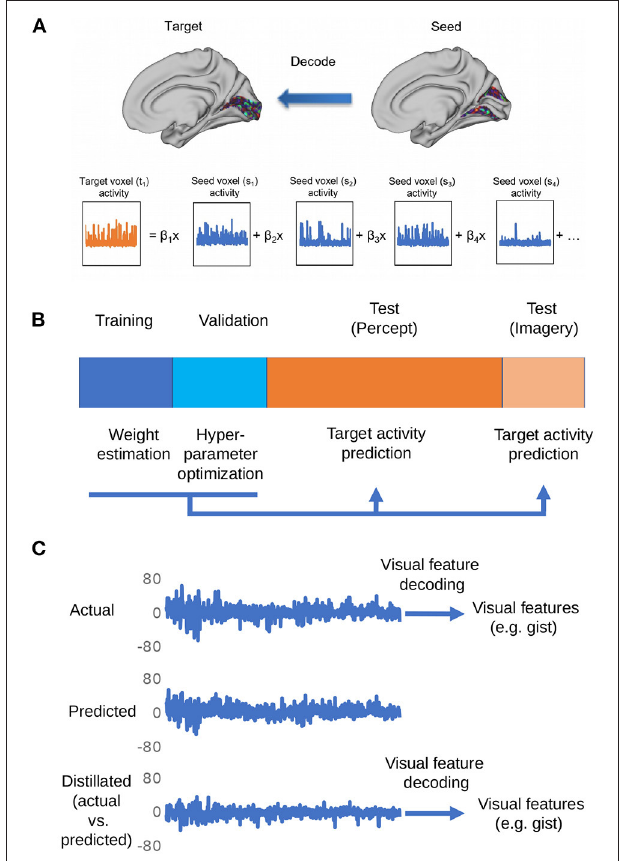
FIGURE 1 | Depiction of the procedures for the proposed distillation analysis. (A) Voxel activity in the target region is predicted by a weighted linear summation of all the voxel activities in the seed region. By repeating this procedure for all the voxels in the target region, the whole activity pattern of the target region is predicted. (B) The dataset is divided into four subsets: training, validation, perception, and imagery tests. The training data set is used to estimate weights for region-to-region decoding. The validation data set is used for the optimization of hyperparameters (ridge parameter). The weights estimated by the optimization of hyperparameters was used to predict the target region activity in perception and imagery test datasets. (C) The representative actual/predicted/distilled activity of a voxel in the perception test